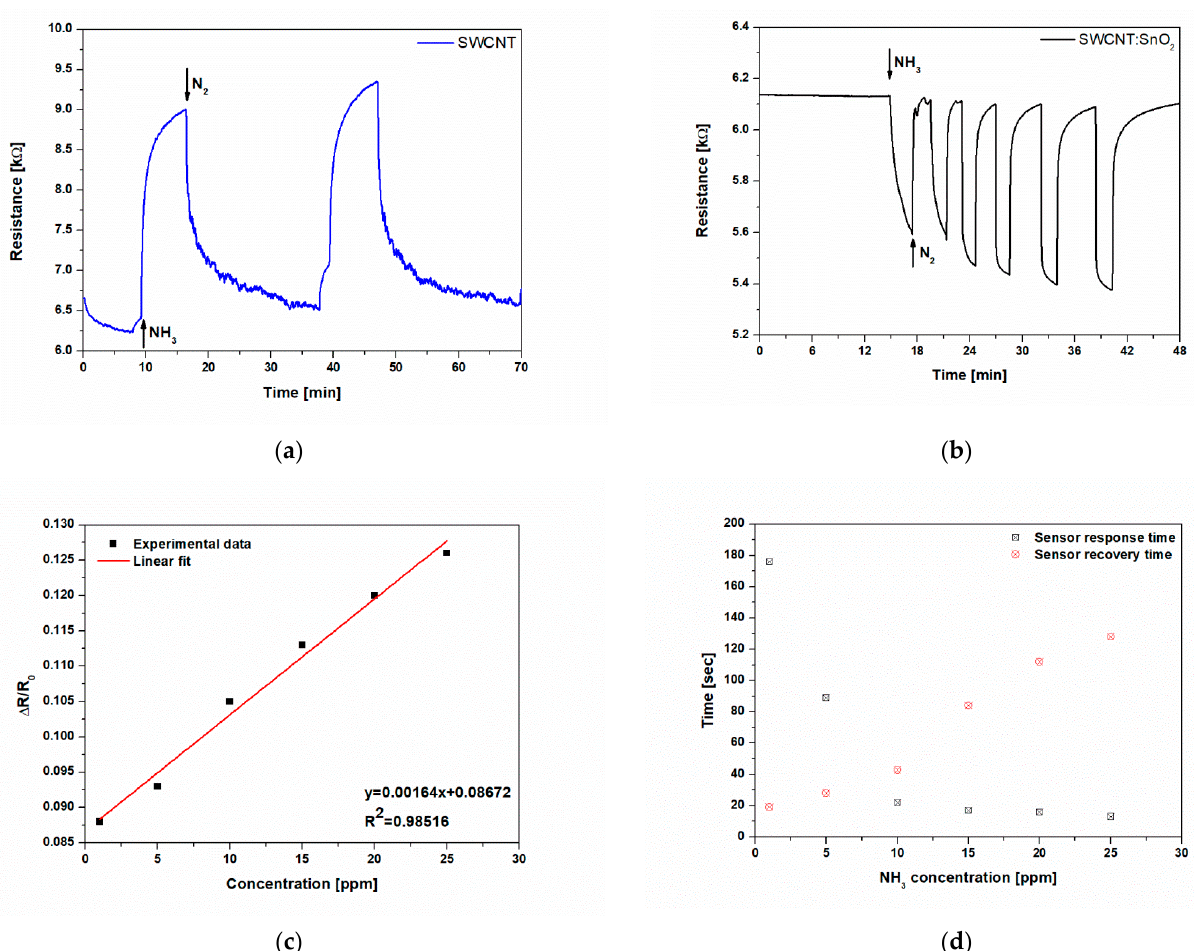
Figure 5. ( a ) Real-time measurements of an SWCNT sensor printed by LIFT collected for 25 ppm of NH 3 ; ( b ) real-time measurements of a SWCNT@SnO 2 sensor printed by LIFT collected for different concentrations (1–25 ppm) of NH 3 ; ( c ) SWCNT@SnO 2 sensor response as a function of NH 3 concentration at room temperature in air, depicting a good linear relation; ( d ) response and recovery times for the SWCNT@SnO 2 sensor printed by LIFT exposed to different concentrations of NH 3 (1–25 ppm).